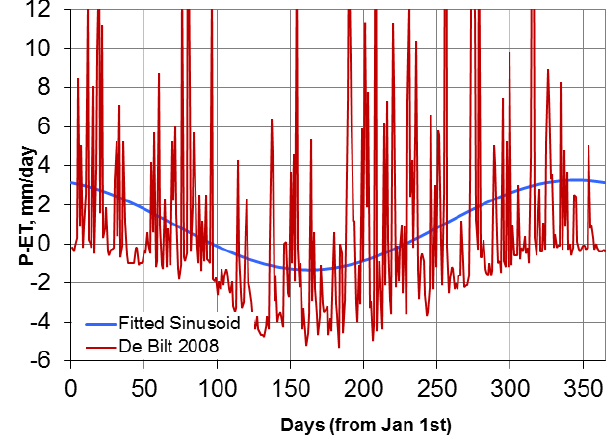
Fig. 3. Daily weather data from De Bilt 2008, The Netherlands (KNMI) and a recharge sinus (fitted with average weather date from 1971–2000) used for numerical